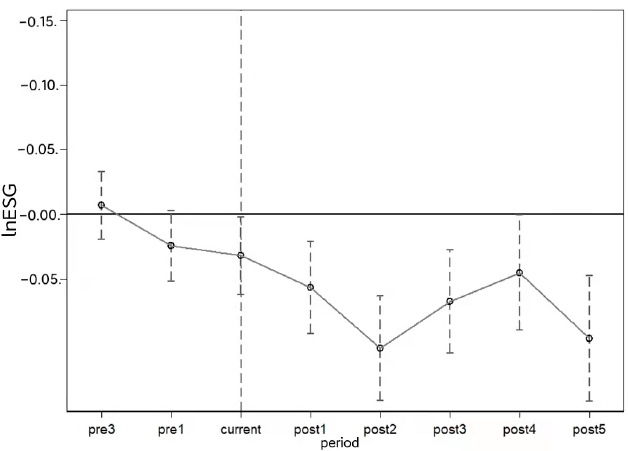
Figure 1. Parallel trend test: logarithm of corporate ESG performance.